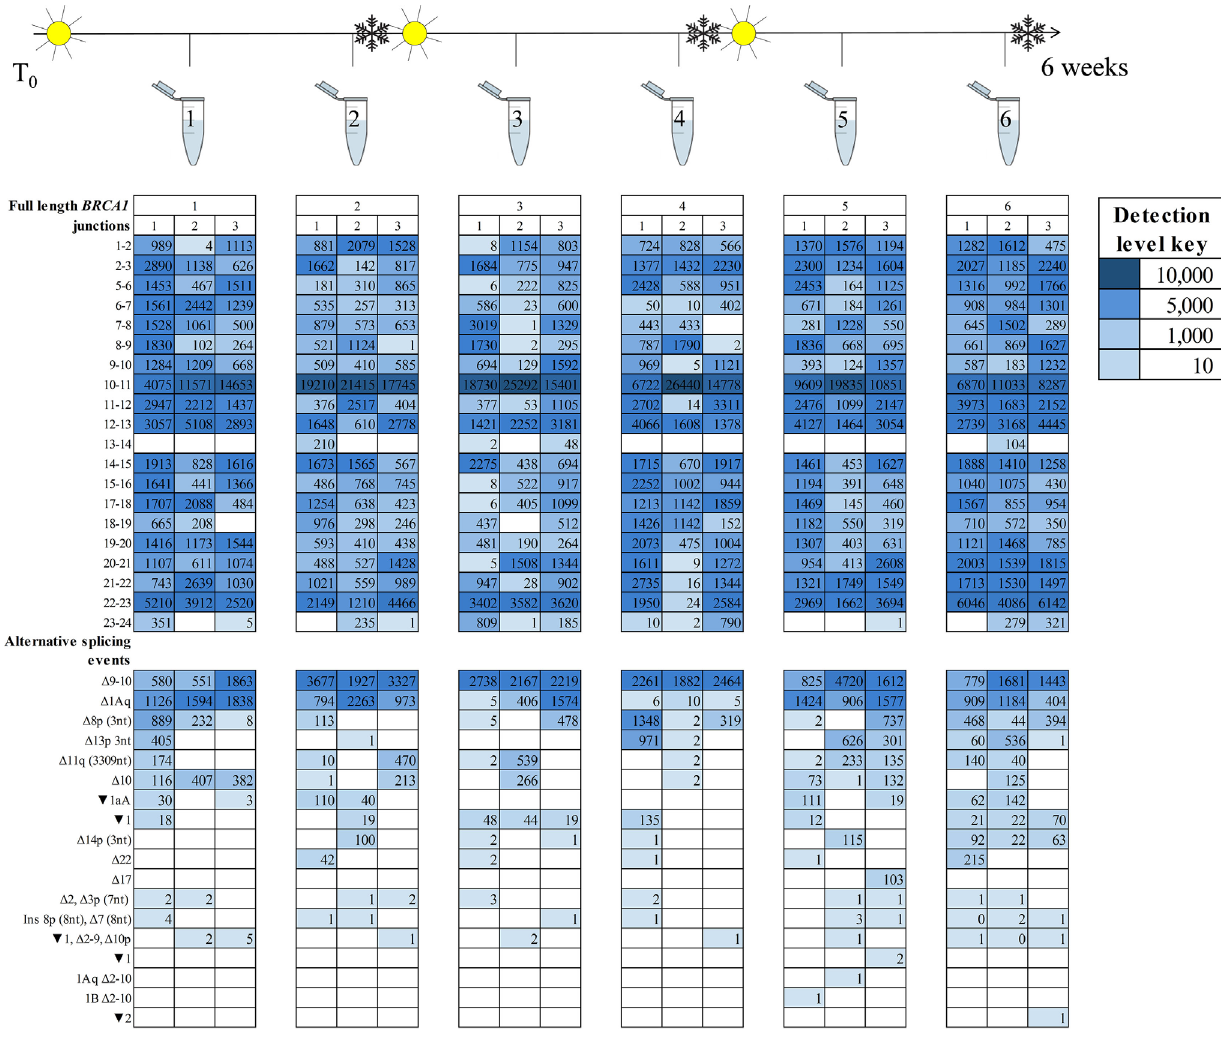
FigUre 3 | BRCA1 mRNA isoforms detected at six time points in an lymphoblastoid cell line (sample #7, Table S1 in Supplementary Material) treated with an nonsense-mediated decay inhibitor. A freeze–thaw process was undertaken after time points two and four. Three technical replicates are listed under each time